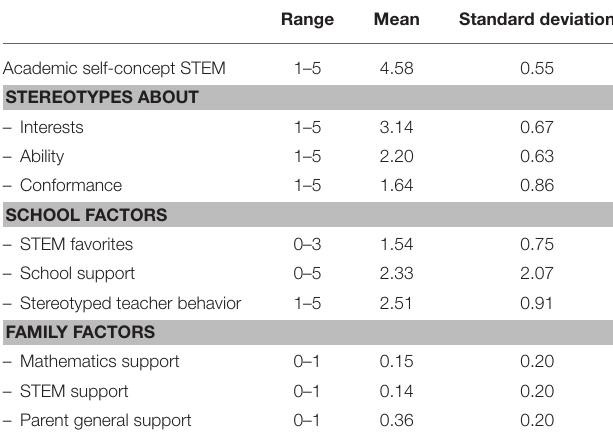
TABLE 2 | Ranges, means, and standard deviations for the reported